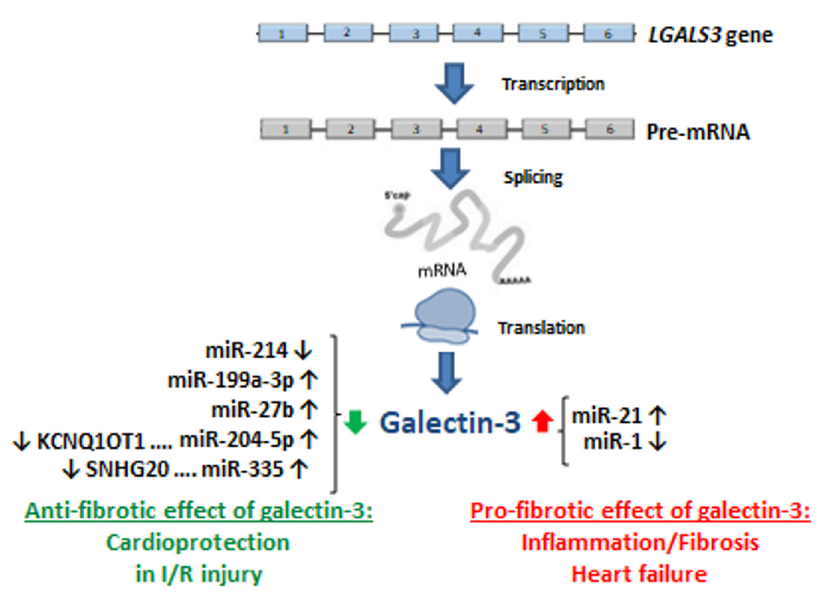
Figure 3. ncRNAs modulation of LGALS3 gene expression in cardiovascular diseases. miR— microRNA; SNHG20—Small Nuclear RNA Host Gene 20; KCNQ1OT1—KCNQ1